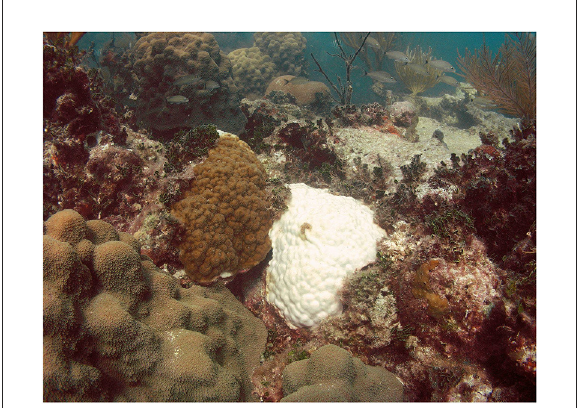
FIGURE1 An example of intraspecific variation in a coral population: two Porites astreoides colonies exhibiting different bleaching responses to thermal stress despite sharing the same environment (and most likely the same Symbiodiniaceae communities). Coral bleaching results when stress breaks down the symbiosis between the host and microalgae, causing a loss of symbionts. The image was captured in the Florida Keys during a warm-water anomaly in October 2015. Photo credit: Ilsa Kuffner, PhD;